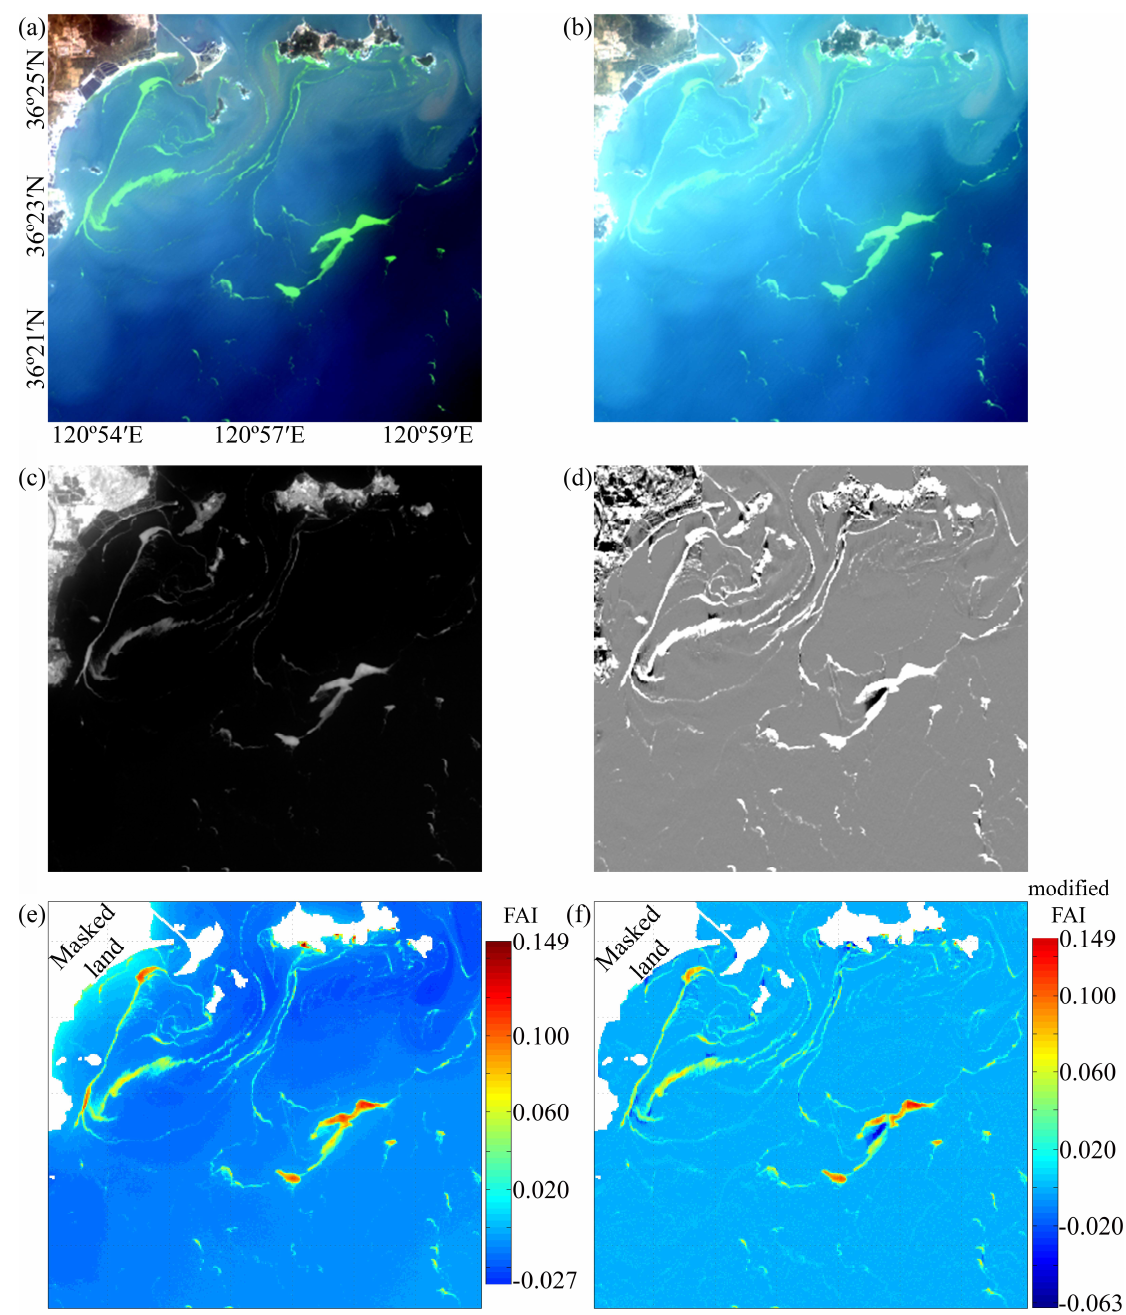
Figure 4. Comparison of macroalgae patches between Landsat-8 based ( a , b ) are true colour RGB (bands 4, 3, 2) images after applying different contrast stretches for better visibility of the macroalgae patches at different locations; ( c ) FAI and ( d ) modified FAI for the smaller ROI area (red rectangle in Figure 1) in path/row 119/35 on 25 July 2015. The colourmaps of FAI and modified FAI are shown as ( e ) and ( f ), respectively.